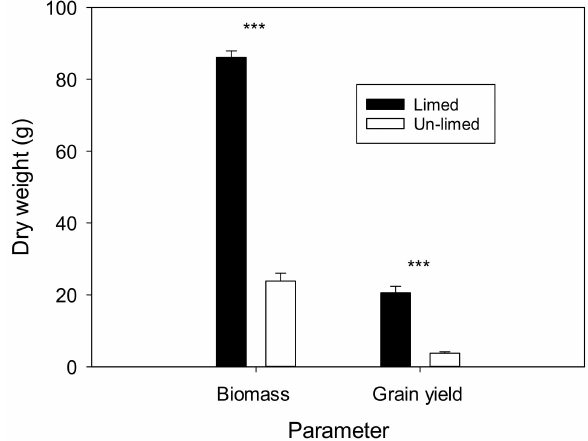
Figure 3. Liming improves biomass and grain yield of Ethiopian accessions grown on an acid soil. Ethiopian accessions (150) were grown in single rows 2 m long on an acid soil and the same soil that had lime incorporated to a depth of 20 cm. Final biomass and grain yield were determined and data of all accessions were combined with error bars indicating the standard error of the mean ( n = 150).